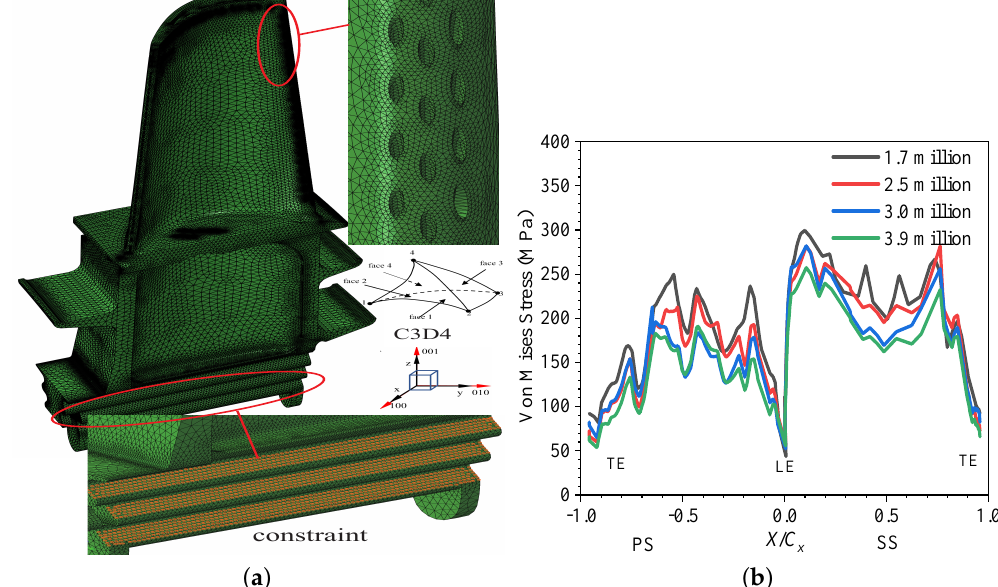
Figure 5. ( a ) Finite element mesh and the constraint of the turbine blade for thermal stress analy- sis; ( b ) Von Mises stress at 50% of the blade span of different numbers of solid elements for grid independence